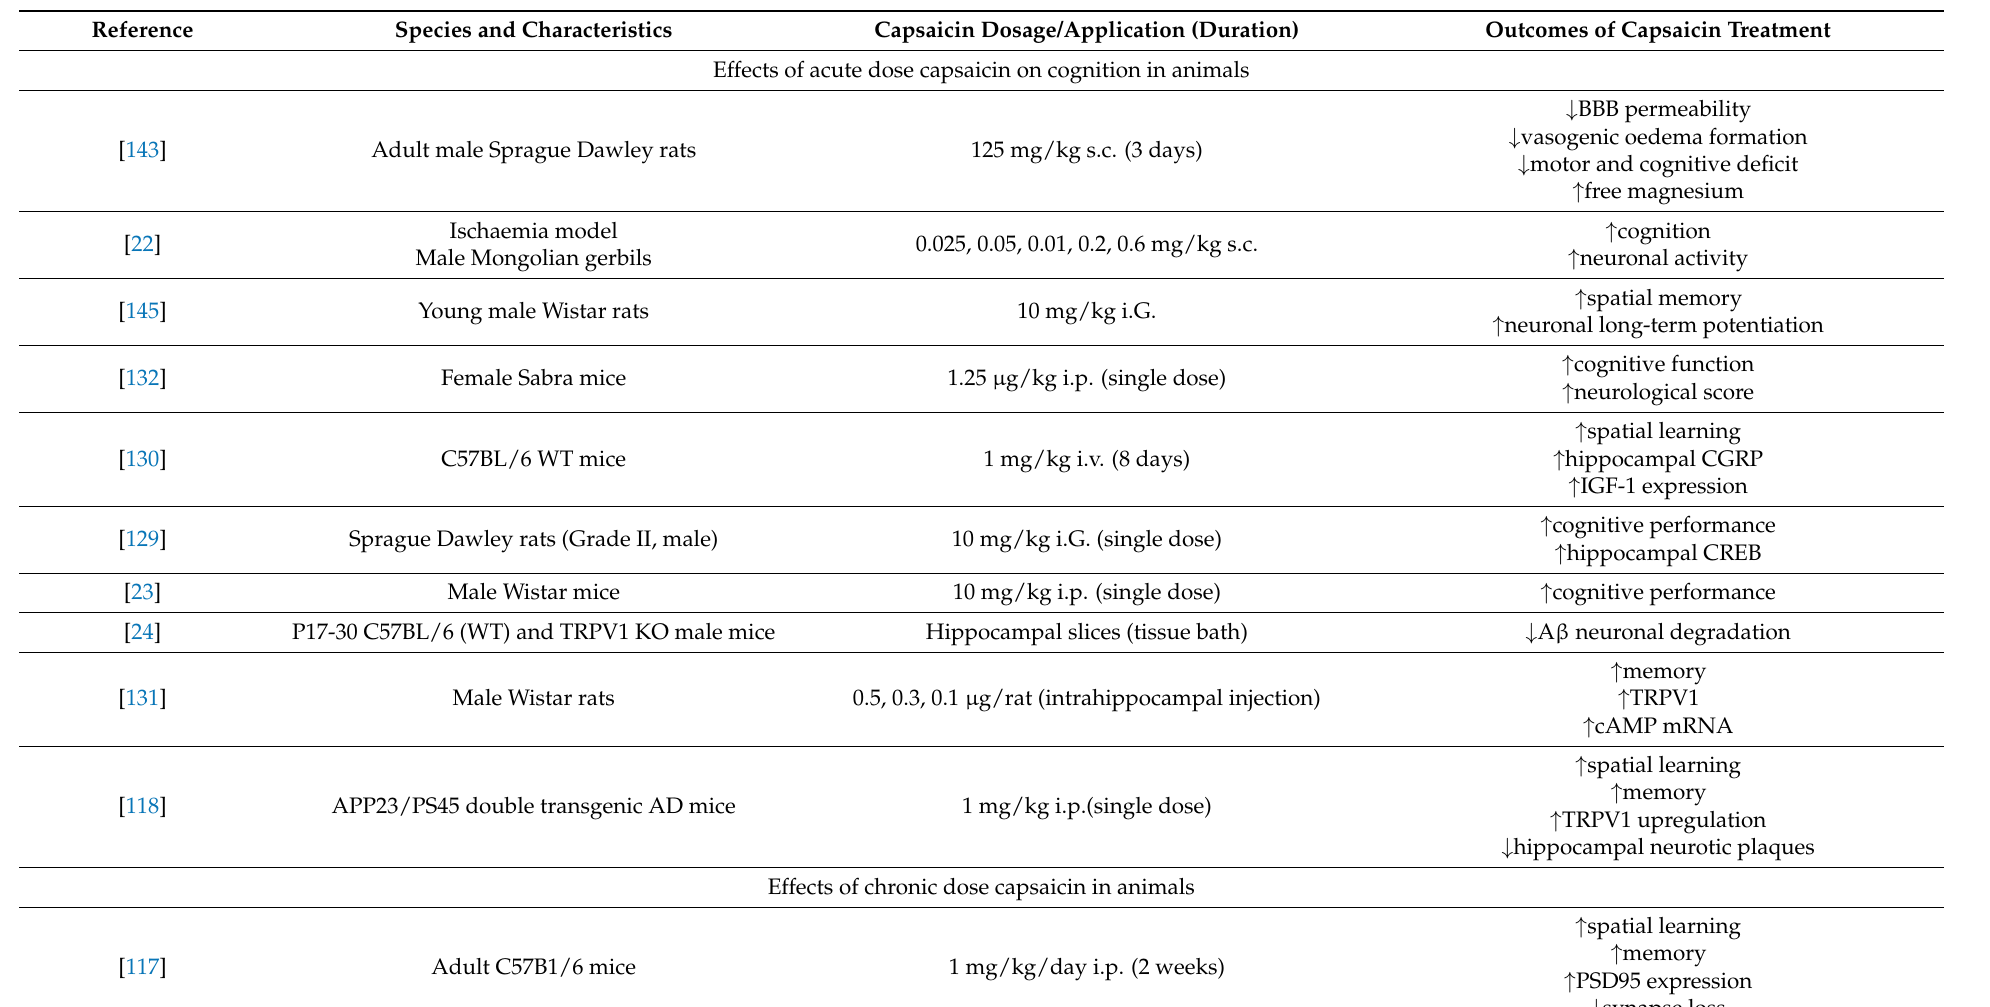
Table 2. Summary of studies that have investigated the effects of capsaicin on cognition and cerebrovascular